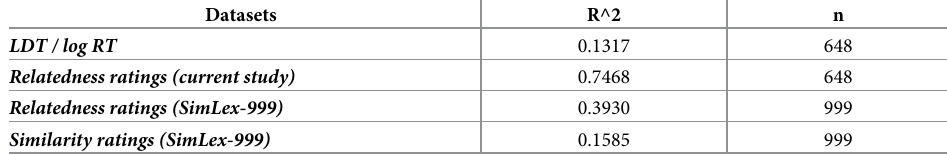
Table 7. The predictiveness of the linear models using the optimized semantic model hyperparameters. These performance numbers can be considered to represent the estimated performance of the models on the independent